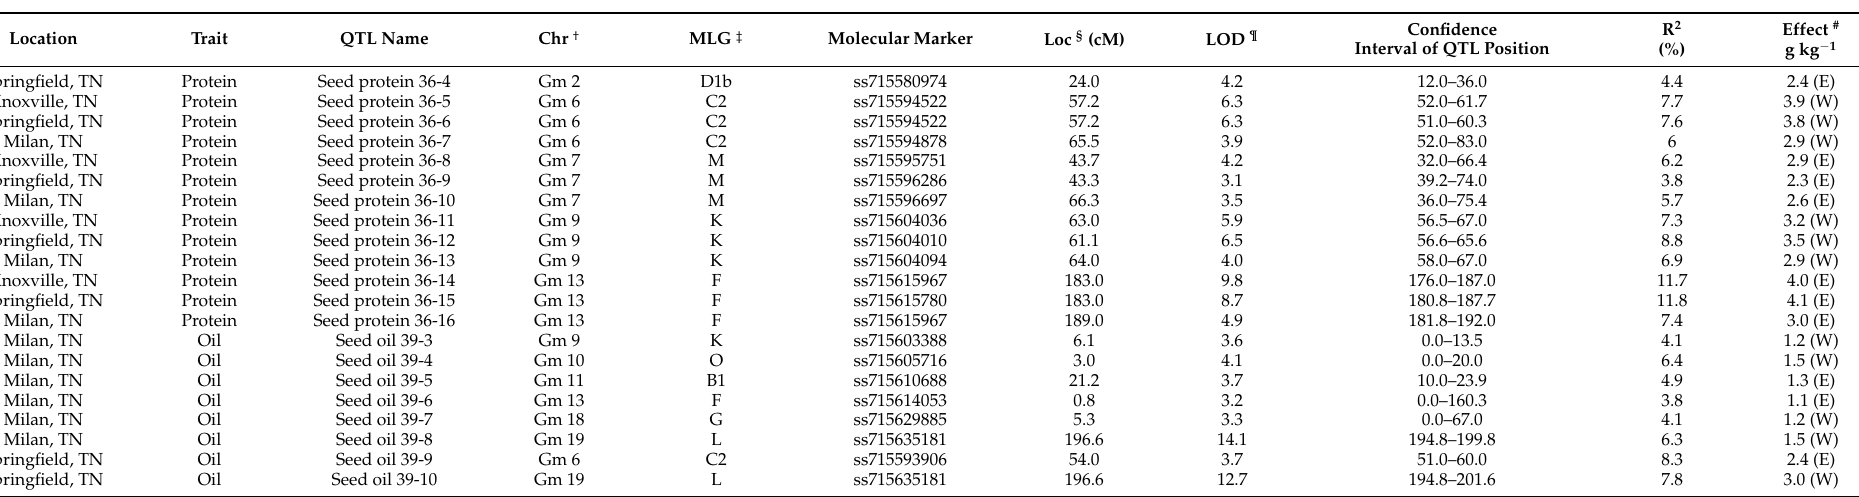
Table 5. Quantitative trait loci identified using R/qtl for composite interval mapping located on various chromosomes associated with protein and oil content in 302 F 5:11 -derived recombinant inbred lines of Essex 86-15-1 × Williams 82-11-43-1 grown in 2013 in Knoxville, TN; Springfield, TN; and Milan,